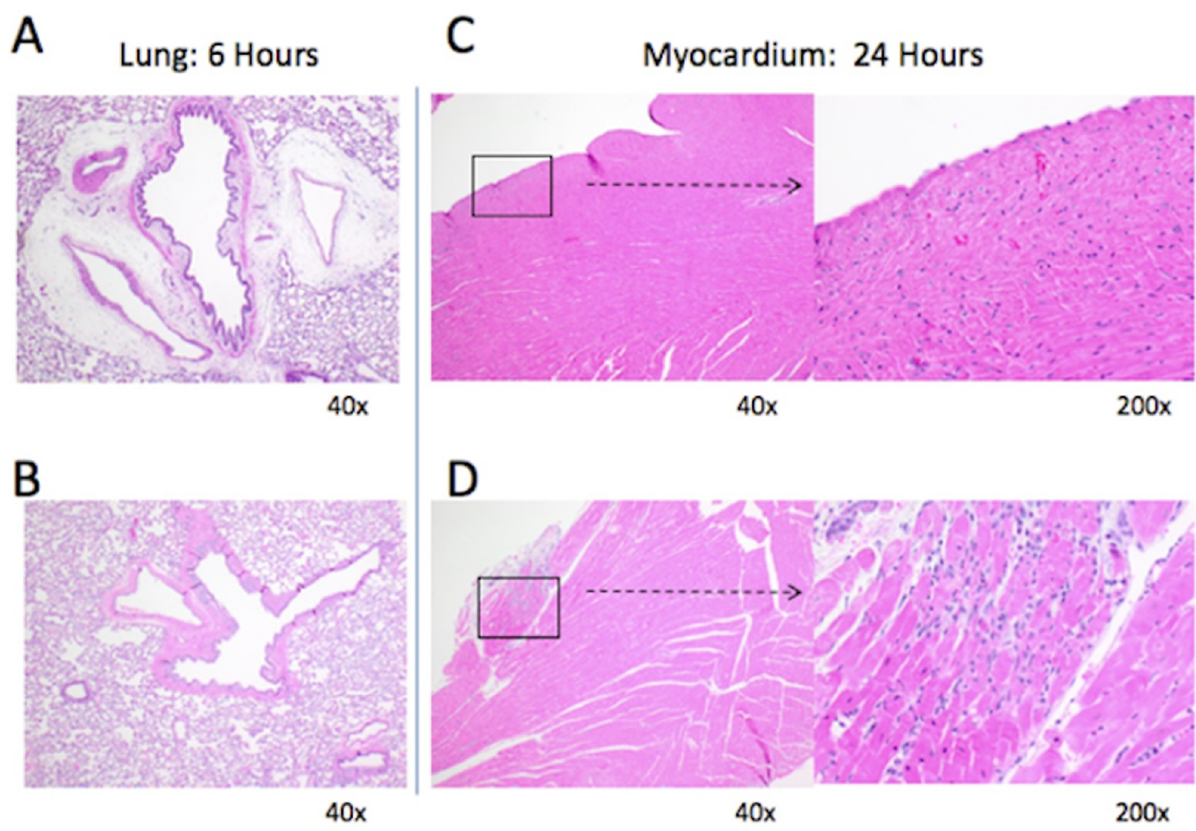
Fig 6. Photomicrographs of lung and myocardial tissue after necropsy in rats subjected to controlled hemorrhagic shock and resuscitation. ( A ) Lung tissue at 6 hours post-injury in vehicle control (normal saline) treated rat with pulmonary perivascular edema present. ( B ) Lung tissue in rat treated with tranexamic acid (TXA) without pulmonary perivascular edema. ( C ) Myocardial tissue at 24 hours post-injury in vehicle control treated rat without myocardial infiltration or degeneration. ( D ) Myocardial tissue in rat treated with TXA with myocardial infiltration and degeneration